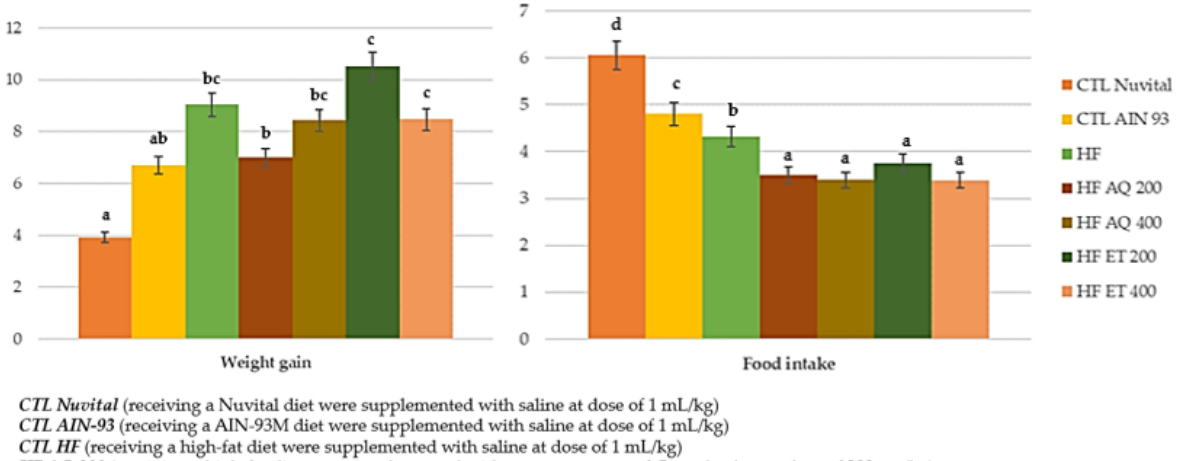
Figure 3. Weight gain (g) and food intake (g) of animals fed a balanced or high-fat diet and supplemented with saline, aqueous extract or ethanol extract of G. gardneriana leaves per day for 8 consecutive weeks. Values expressed as mean ± standard deviation. Different letters indicate a significant difference between groups and groups with the same letter are not significantly different. p < 0.001; n = 6 – 11; ANOVA followed by Tukey post-test.